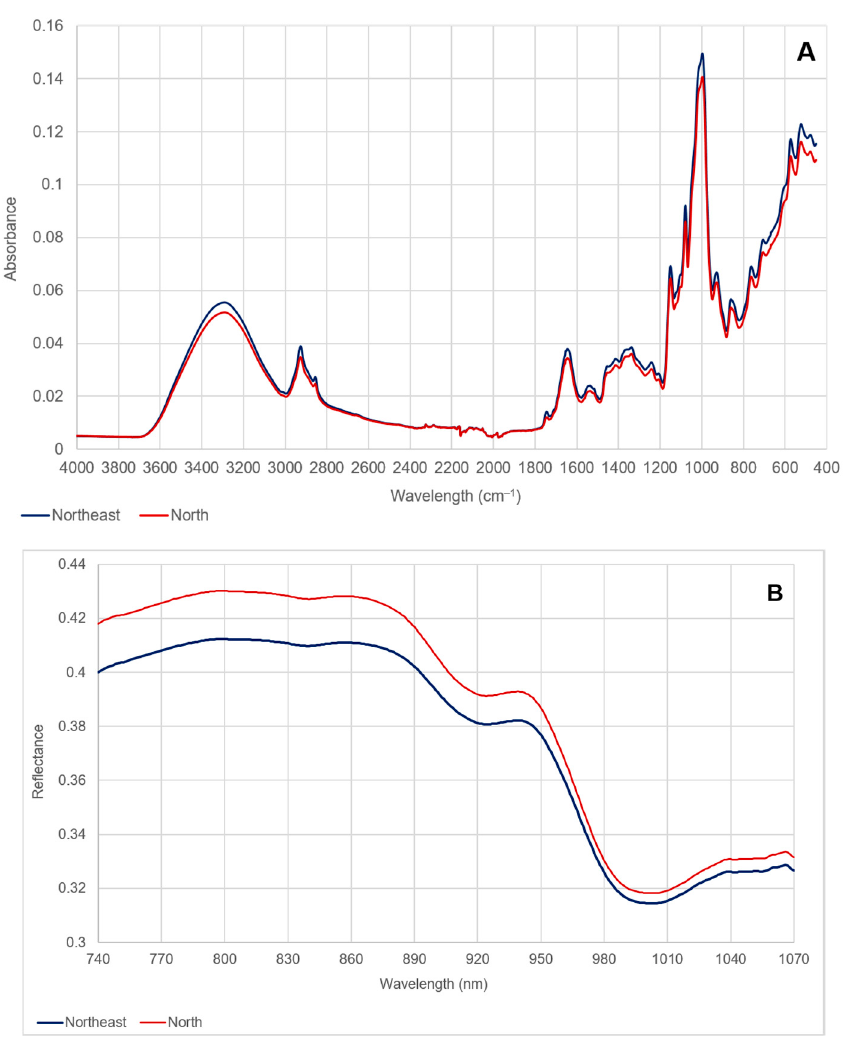
Figure 1. Mean raw FTIR-ATR ( A ) and NIR ( B ) spectra of Thai Hom Mali rice from the northern and northeastern regions (year 2019). Spectra from 2018 are similar and are not shown.